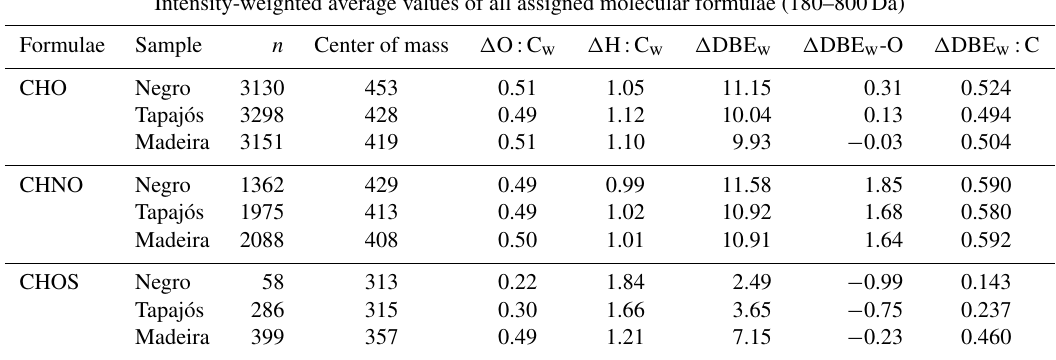
Table 1. Differences in SPE-DOM between the Rio Negro, Rio Tapajós and Rio Madeira identified by ESI-FT-ICR-MS. Intensity-weighted average values of all assigned molecular formulae (180–800Da)